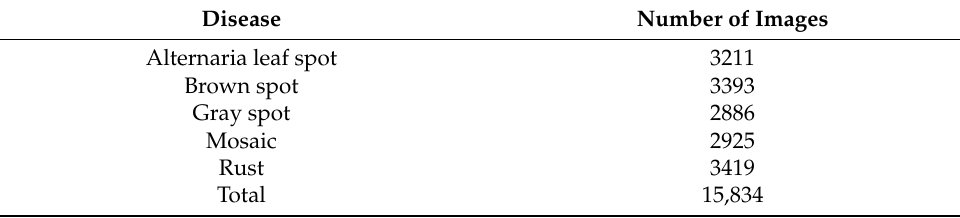
Table 1. The specific distribution of apple leaf disease dataset training set after data enhancement.